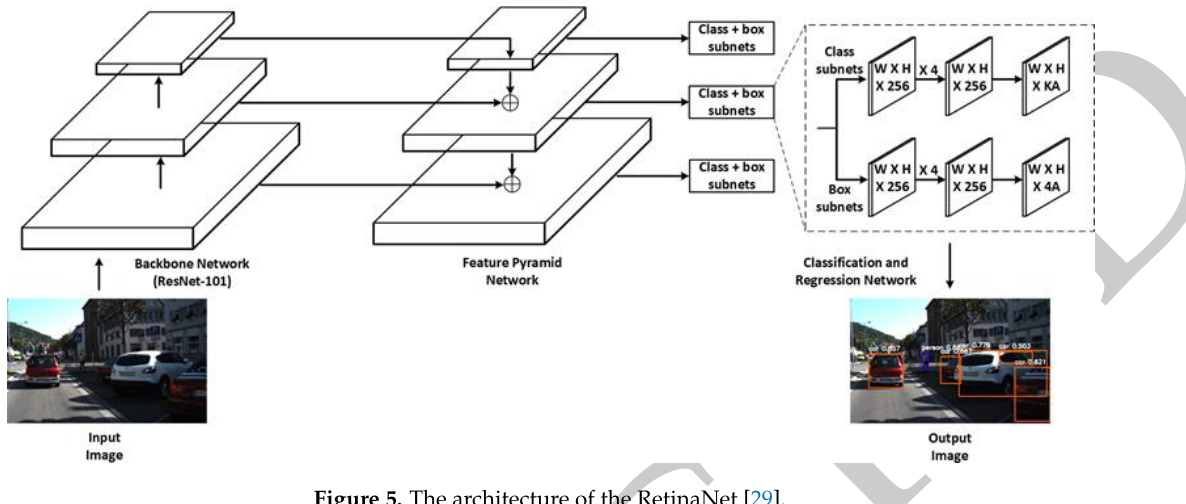
Figure 5. The architecture of the RetinaNet [29].